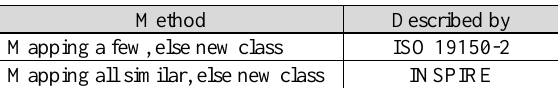
Table 2. Levels of mapping to existing data